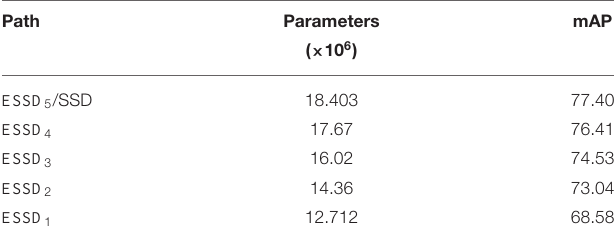
TABLE 3 | Results from the ESNO system with pruning enabled ( ρ =